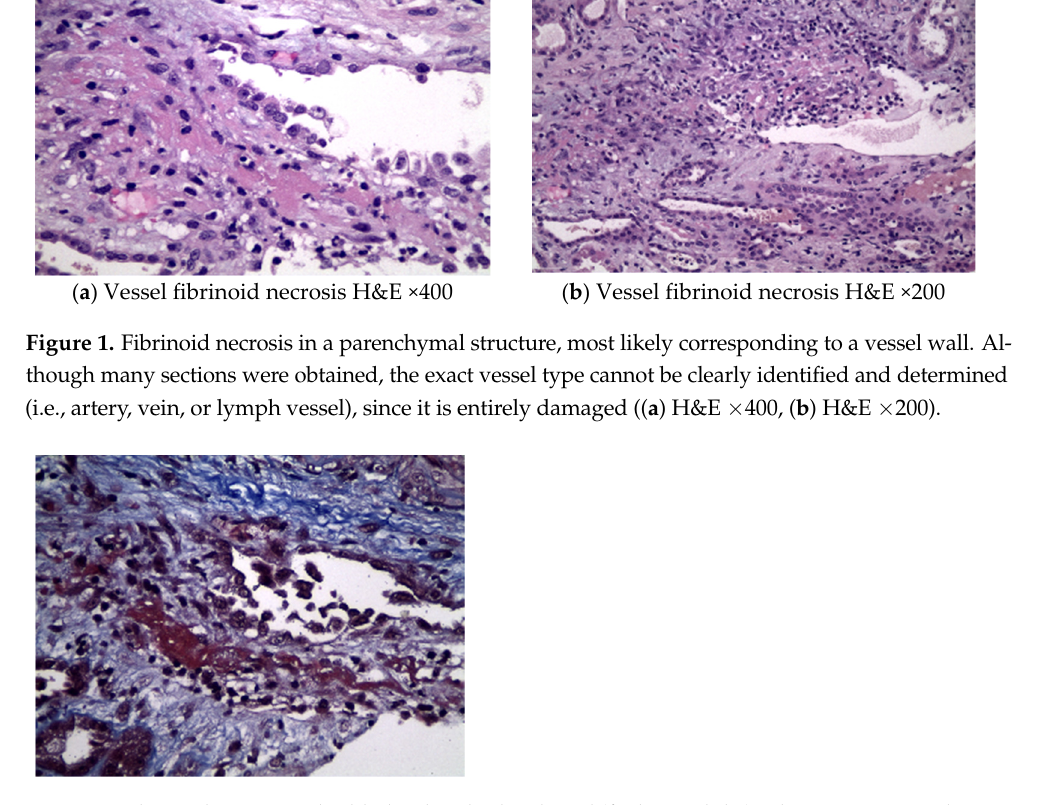
Figure 2. Fibrinoid necrosis is highlighted with a bright red (fuchsinophilic) color in Masson tri- chrome stain (Masson ×400).